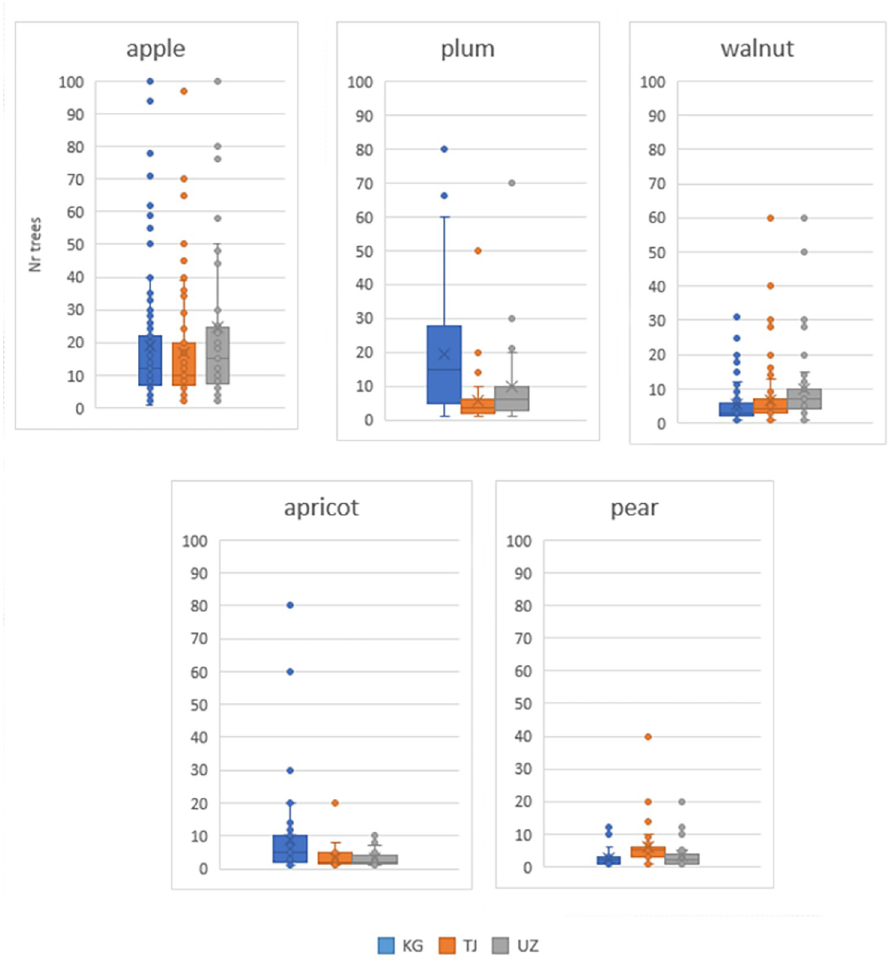
Fig 5. Boxplot with number of individuals for each of the top five most abundant tree species in home gardens of each country. Average values are calculated considering only those home gardens where each species occurred.